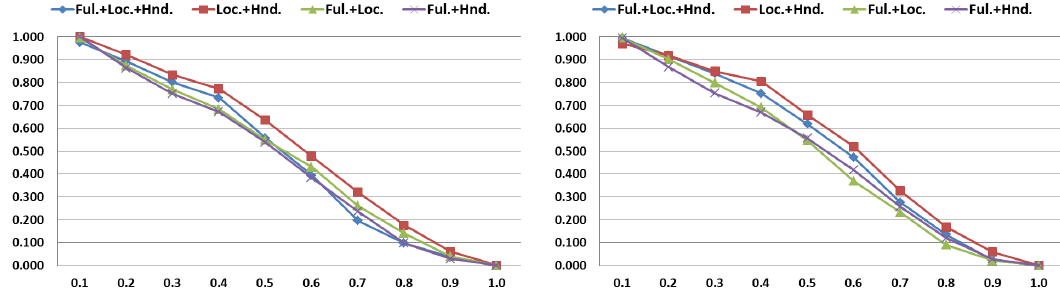
Figure 9. AR results of all feature combinations (hand-location, hand, and full-frame) for our multi-stream RNN. X -axis defines the different temporal intersection-over-union (tIoU) thresholds. ( left ) Validation results. ( right ) Testing results.